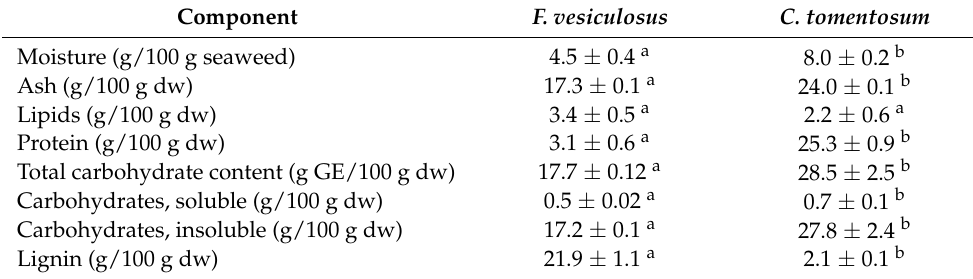
Table 1. Proximate composition of the two seaweeds studied (mean ± SD).